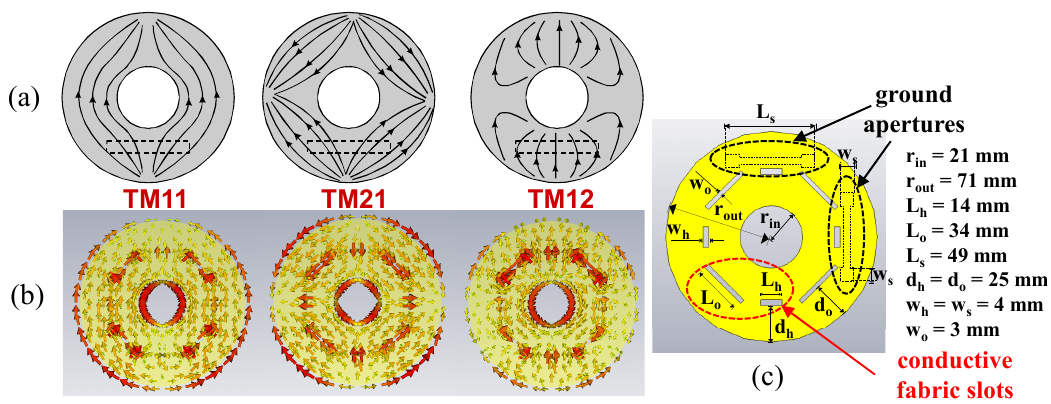
Figure 5. ( a ) Theoretical and ( b ) simulated electric current patterns for the ring antenna selected modes. ( c ) Final layout of the tri-band annular ring